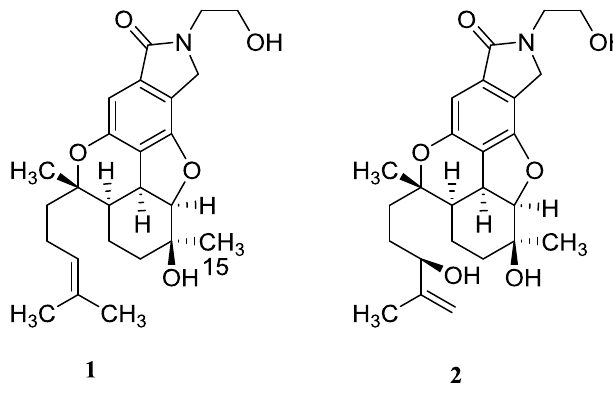
Figure 1. Structures of compounds 1 and 2 .